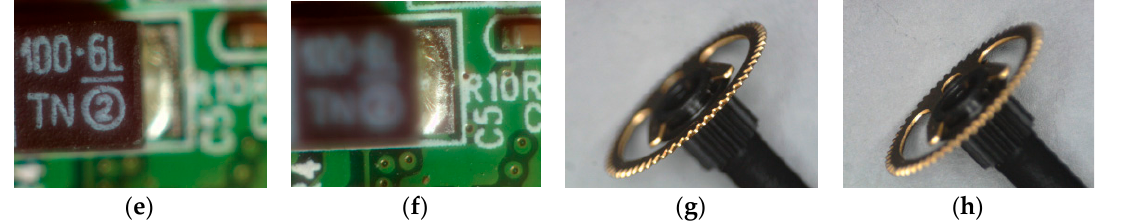
Figure 9. Our test focal stacks (only two images among them are shown). ( a )( b ) “Battery”, ( c )( d ) “Screw”, ( e )( f ) “PCB”, ( g )( h ) “Tool”.